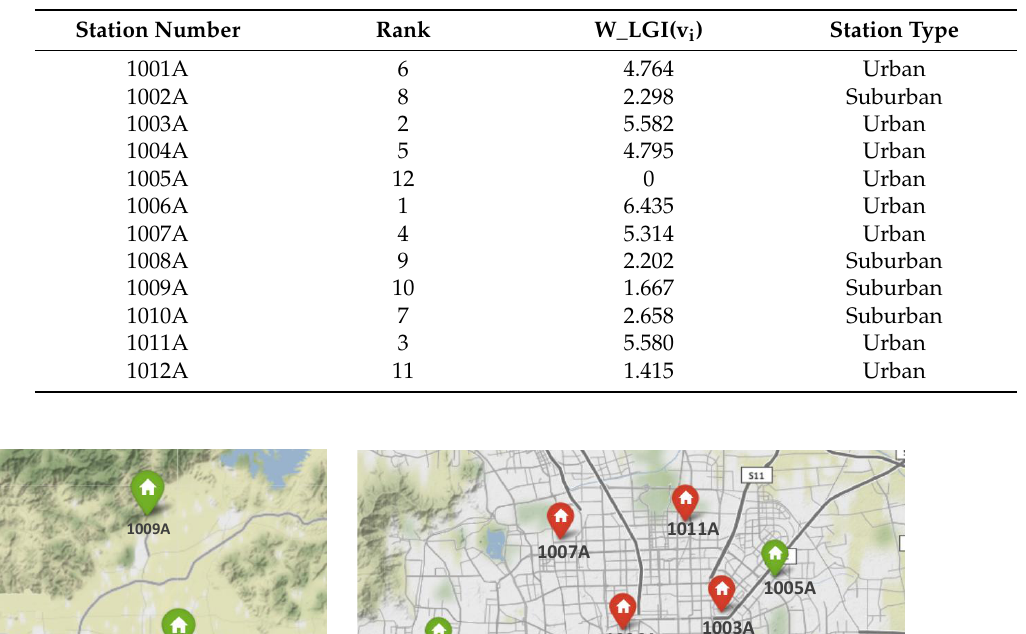
Table 4. Ranking of influential nodes in the air pollution spatial correlation weighted network of Beijing.